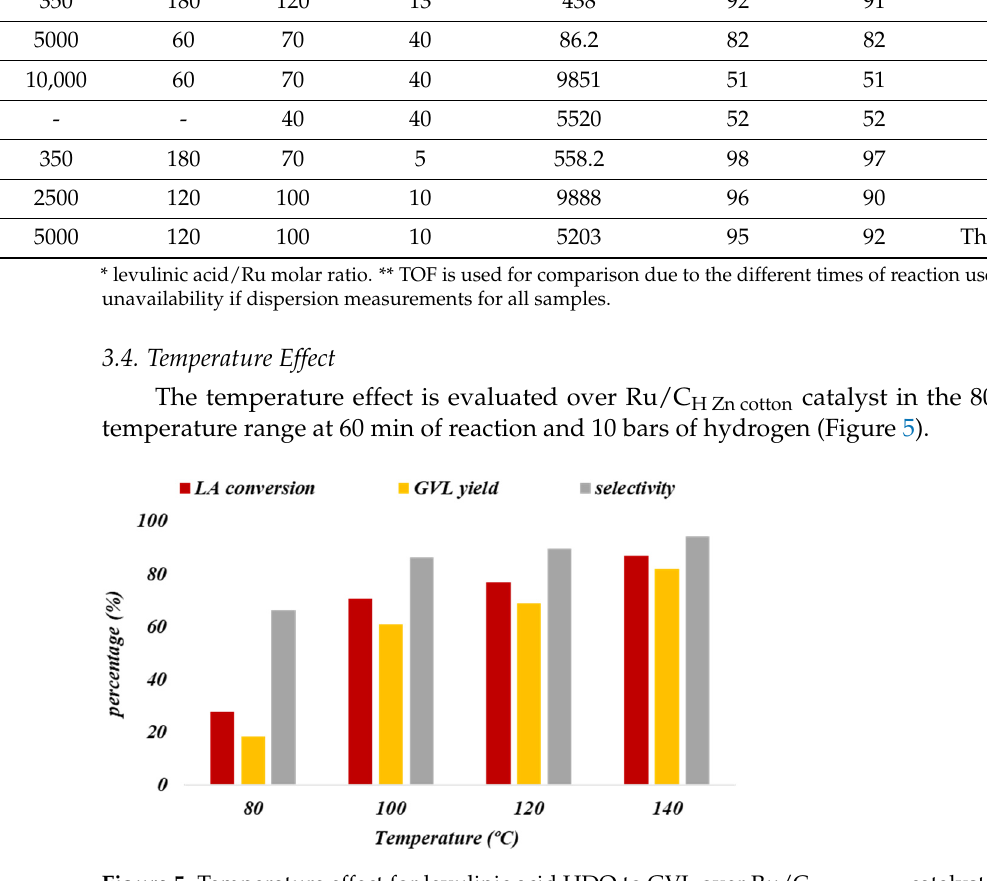
Figure 5. Temperature effect for levulinic acid HDO to GVL over Ru/C H Zn cotton catalyst.